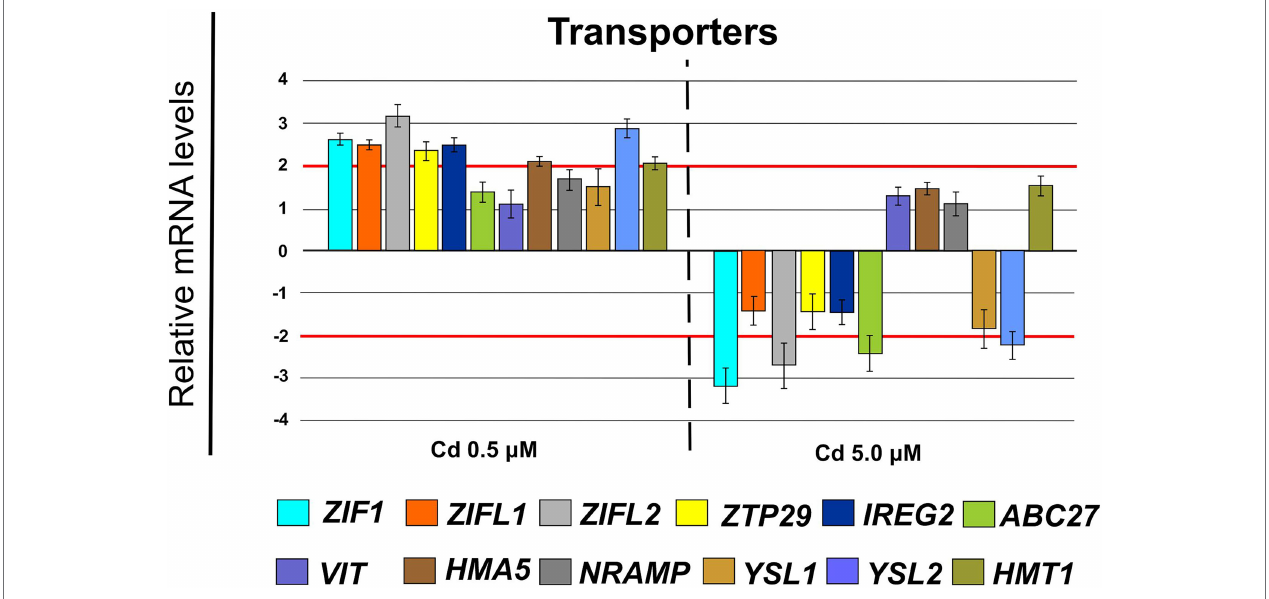
FIGURE 10 | Expression analysis of genes coding for transporters in roots (15 days from sprouting and from the start of Cd treatments). ZIF1 ( zinc-induced facilitator 1 ), ZIFL1 ( zinc-induced facilitator-like 1 ), ZIFL2 ( zinc-induced facilitator-like 2 ), ZTP29 ( zinc transporter 29 ), IREG2 ( iron regulated 2 ), ABC27 ( ATP-binding cassette 27 ), VIT ( vacuolar iron transporter ), HMA5 ( heavy metal atpase 5 ), NRAMP ( Natural resistance-associated macrophage protein metal ion transporter 2 ), YSL1 ( yellow stripe like 1 ), YSL2 ( yellow stripe like 2 ), HMT1 ( heavy metal tolerance 1 ). Red lines highlight the fold changes 2 and − 2 to graphically identify the genes differentially expressed.